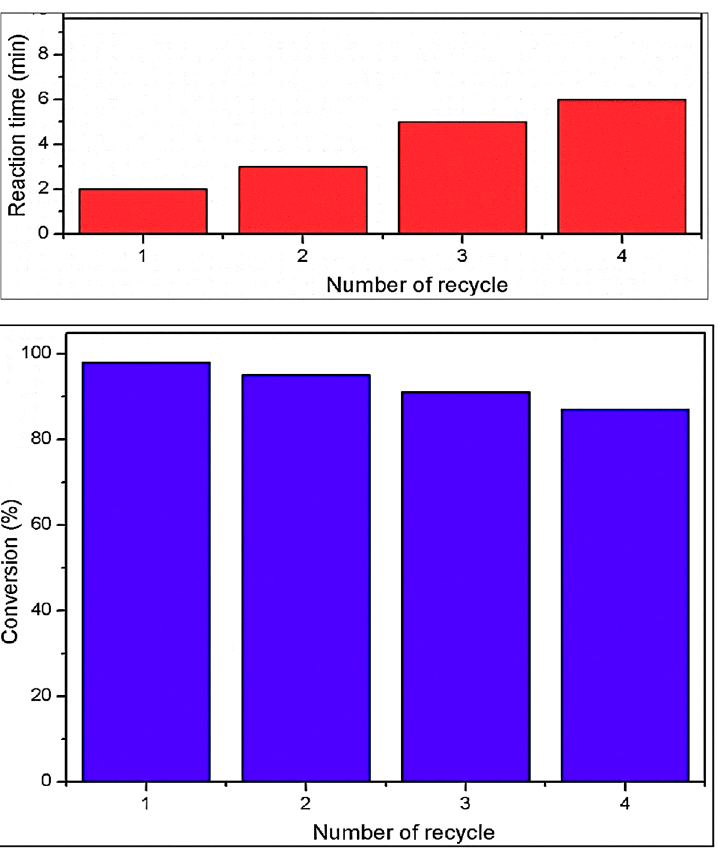
Figure 7. Reusability of amine-modified GO/APTES/Fe used as a catalyst for the reduction in 4-NP. Reprinted from [24] with permission from Elsevier.